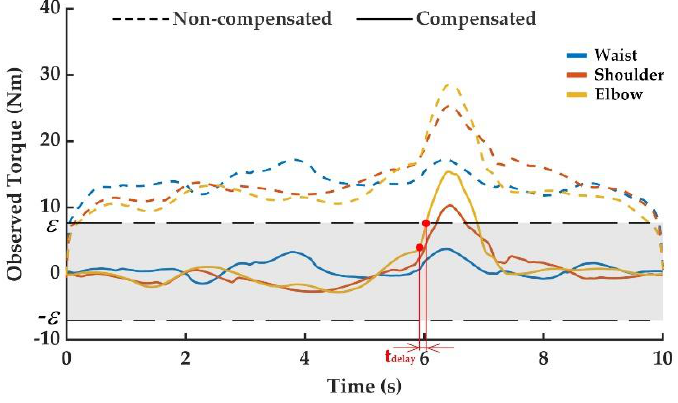
Figure 6. External torque observation in the second collision experiment.